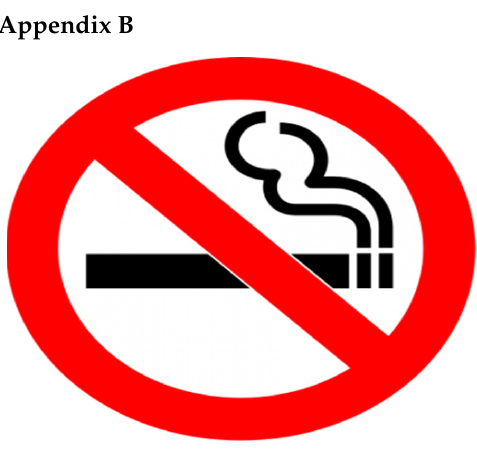
Figure A2. International no smoking symbol.